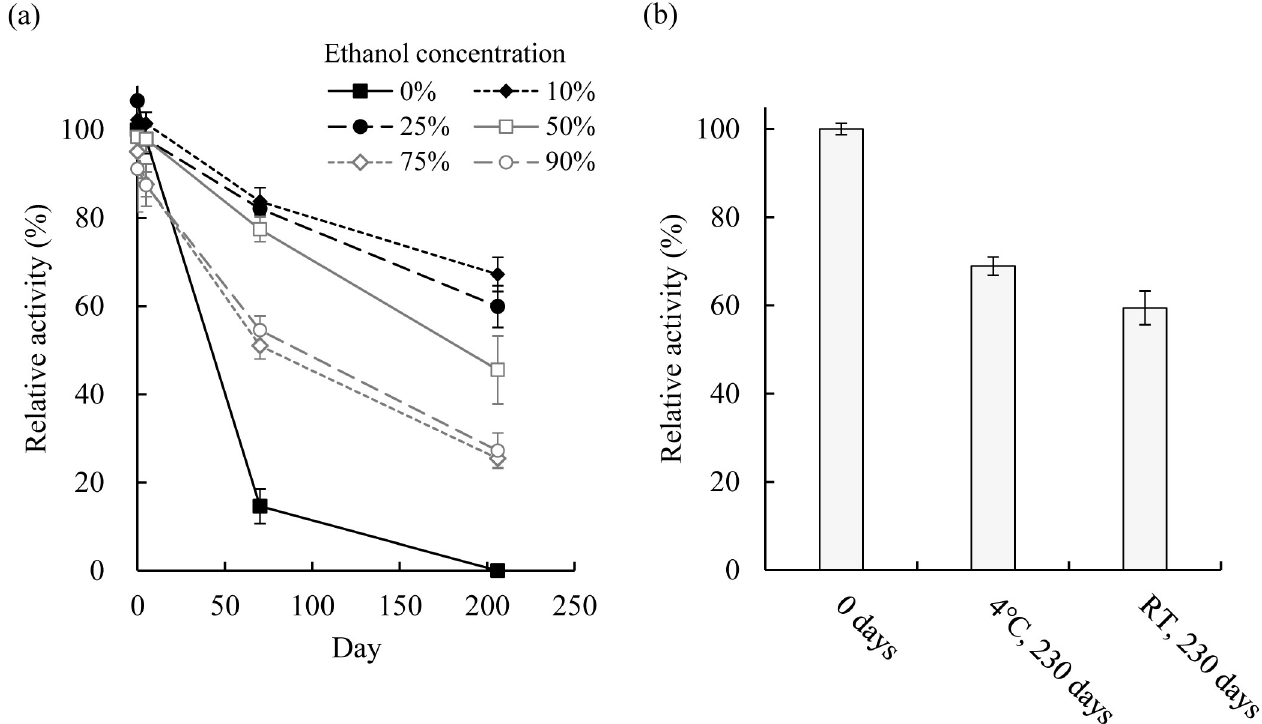
Fig 2. (a) Temporal changes in PaE activity in culture filtrates containing various amounts of ethanol. Ethanol was added to a final concentration of 0%, 10%, 25%, 50%, 75%, or 90% (v/v), and then the enzyme solution was stored at ambient temperature (RT) for up to 206 days. Relative activities are expressed as a percentage of the initial (0 day) activity of the control culture filtrate (containing 0% ethanol). Data are means ± standard deviation (SD) ( n = 3). (b) Residual PaE activity in the solution of partially purified PaE containing 20% ethanol. Partially purified PaE obtained by preparation with the combination of ammonium sulfate precipitation and ethanol precipitation was dissolved in 20% ethanol and stored at 4˚C or RT for 230 days. Relative activities are expressed as a percentage of the initial (0 day) activity. Data are presented as the mean ± SD ( n = 3).